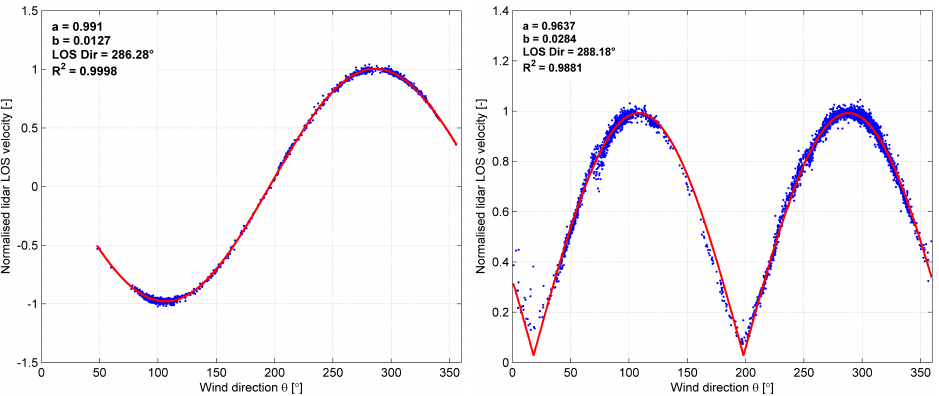
Figure 7. Lidar response to the wind direction. Left : 5B, cosine fitting; Right : ZDM, rectified cosine